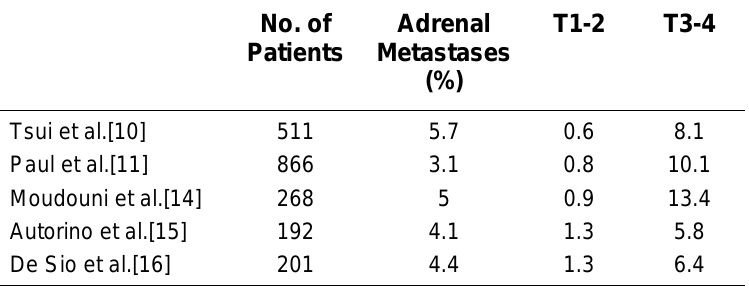
Incidence of Adrenal Metastasis in T1-2 and T3-4 Tumors No.